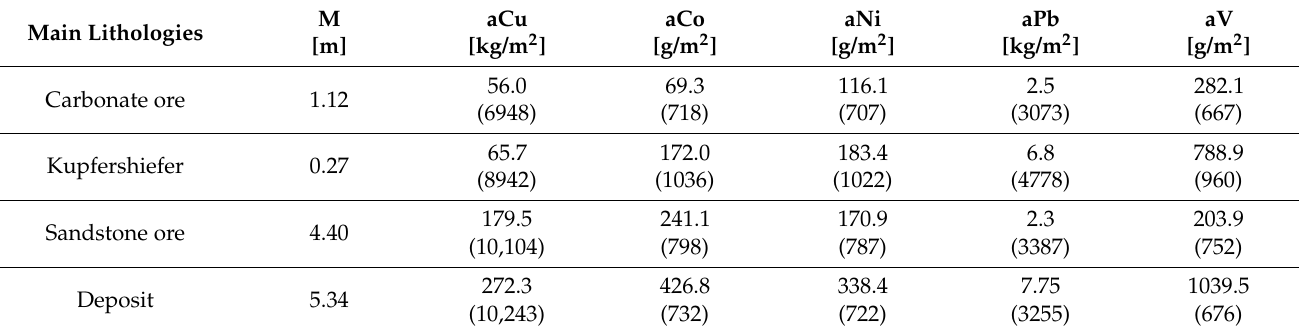
Table 2. Arithmetic means of the thickness of the deposit (M) and the abundance of elements (a) in the main lithologies and the deposit (the number of data sets is presented in